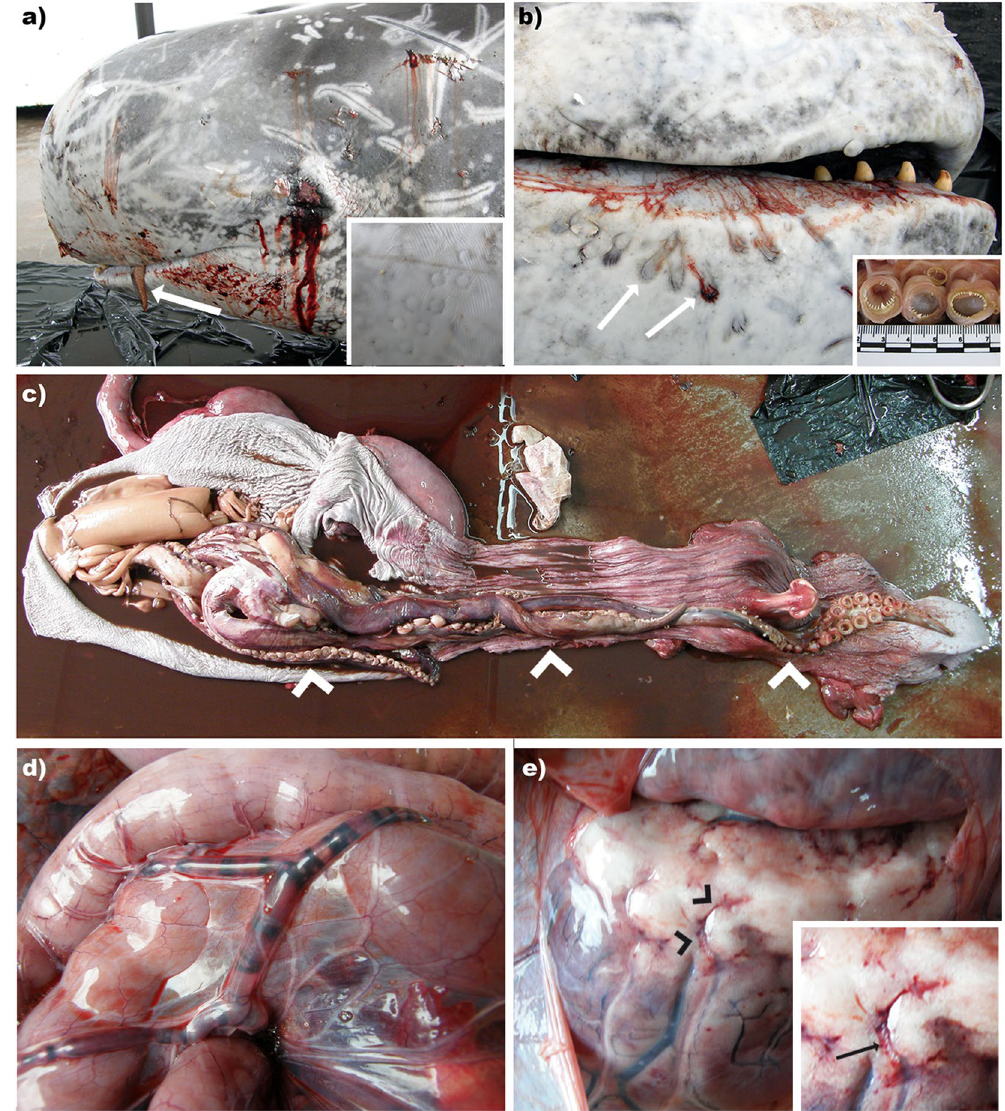
Figure 1. Gross findings of Case 1. ( a ) Squid tentacle partially fixed to the mandible (arrow). Inset: Squid tentacle suckers’ impressions on the cervical skin. ( b ) Mild multifocal and superficial ring-shape cutaneous lacerations caused by squid’s tentacle suckers and hooks (arrows). Inset: gross detail of squid’s tentacle suckers and hooks. ( c ) Upper digestive tract content of case 1, consisting in an entire squid along the oropharynx, oesophagus, and stomach (arrowheads). ( d ) GFVD in the mesenteric veins. ( e ) Mild multifocal haemorrhages following the vascular tracts (arrowheads). Inset: GFVD in the coronary veins associated to petechial haemorrhages